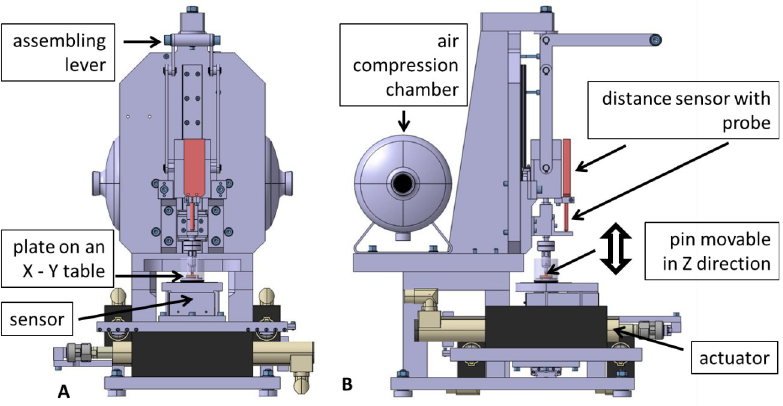
Fig 1. Technical drawing of front (A) and side view (B) of the tribometer in testing mode. The normal force was applied through air pressure on the osteochondral plate via the movable osteochondral pin. The plate was moved on an X–Y table, driven by linear actuators. Height displacements were measured via the distance sensor over the reciprocating trajectories. The experiments were performed in PBS as lubricant. Tubes and cables are not